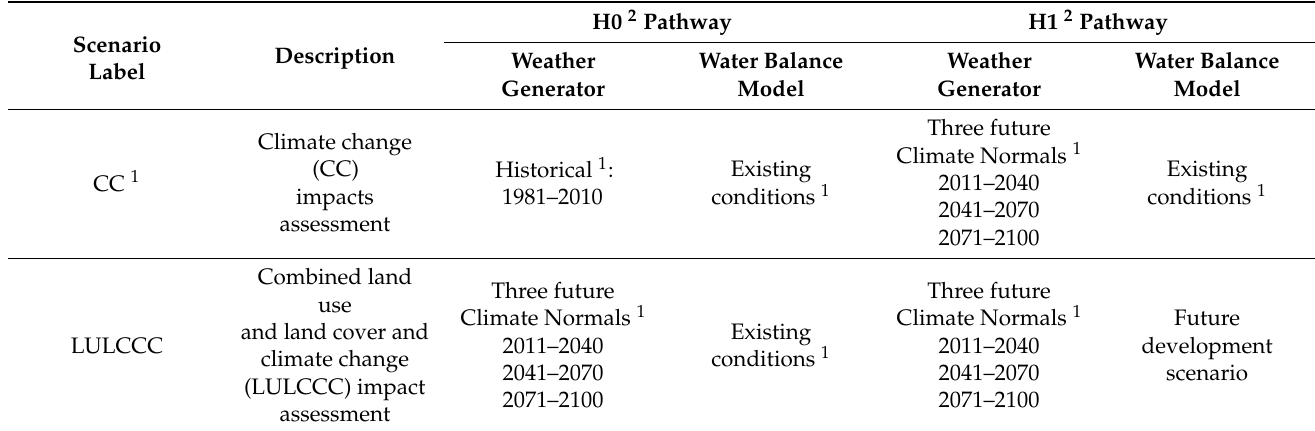
Table 1. Comparative risk assessment